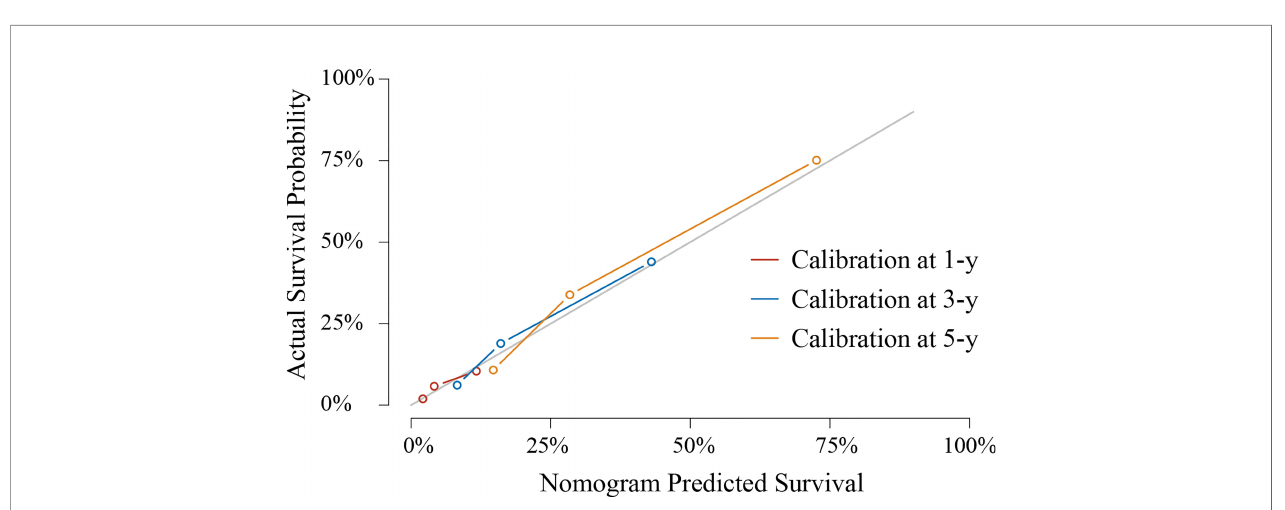
FIGURE 3 | Calibration curves to predict 1-, 3-, and 5-year overall survival in the whole